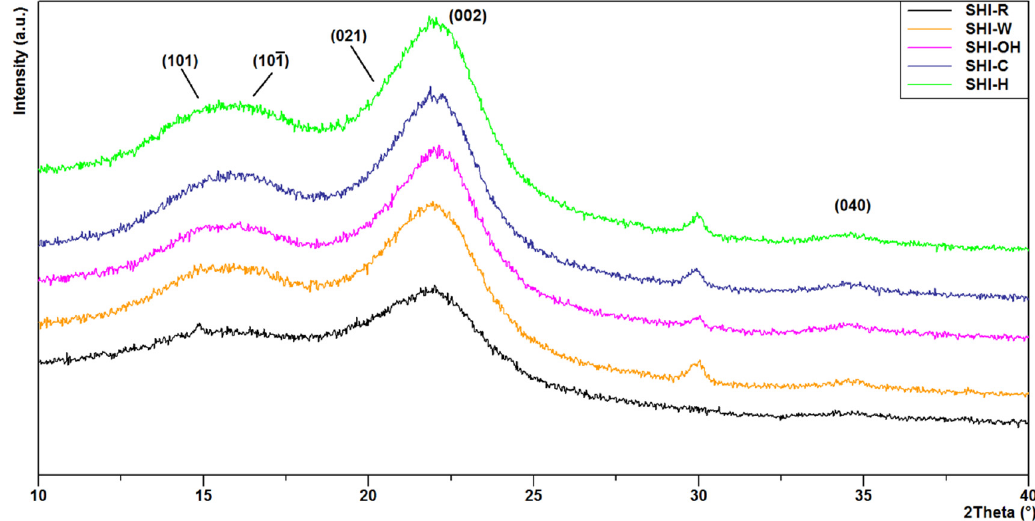
Figure 2. XRD patterns of untreated (SHI-R) and treated (SHI-W, SHI-OH, SHI-C and SHI-H) hemp shive samples. The Miller indices of the main lattice planes of the cellulose are reported in round brackets. Diffraction peaks are indicated as 101, 10 1(cid:3364) , 021, 002, and 040 reflections.